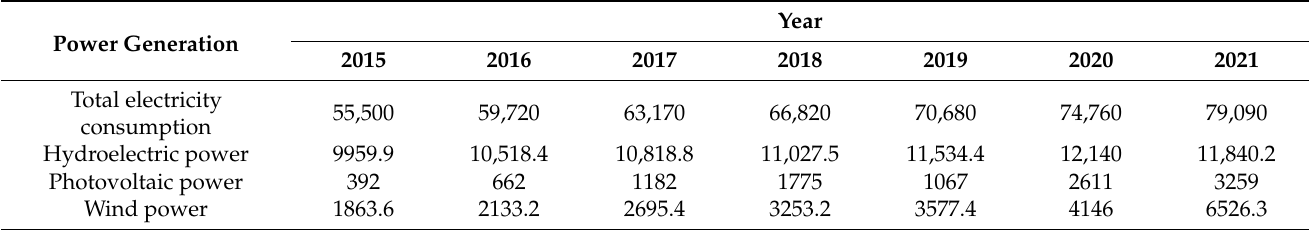
Table 3. Statistics of China’s Clean Energy Generation (Billion kWh).